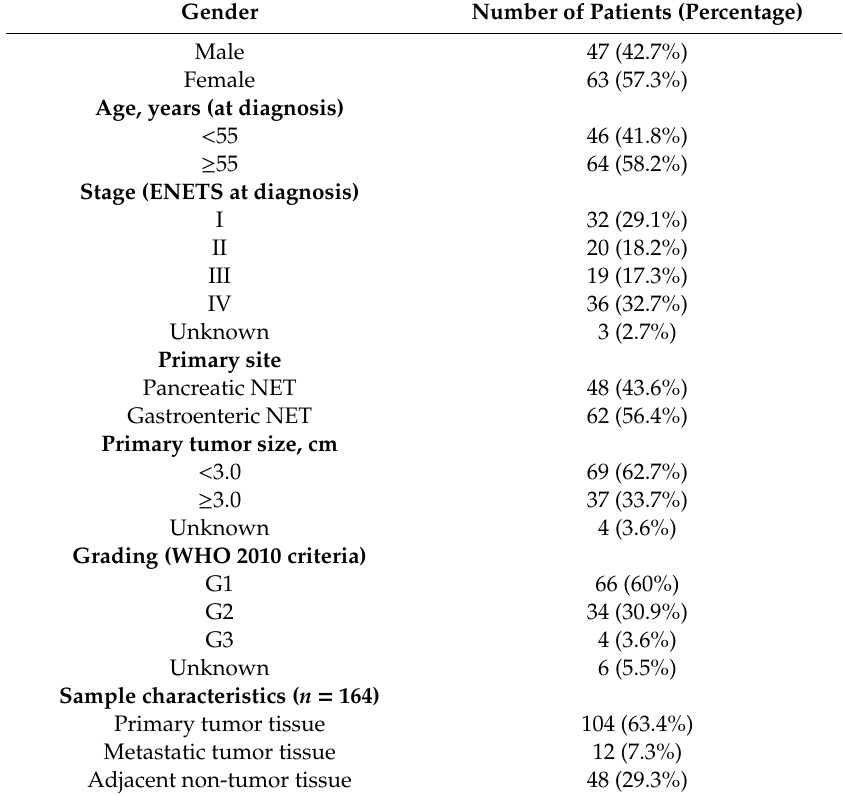
Table 1. Patients’ baseline characteristics ( n = 110) and sample characteristics ( n =